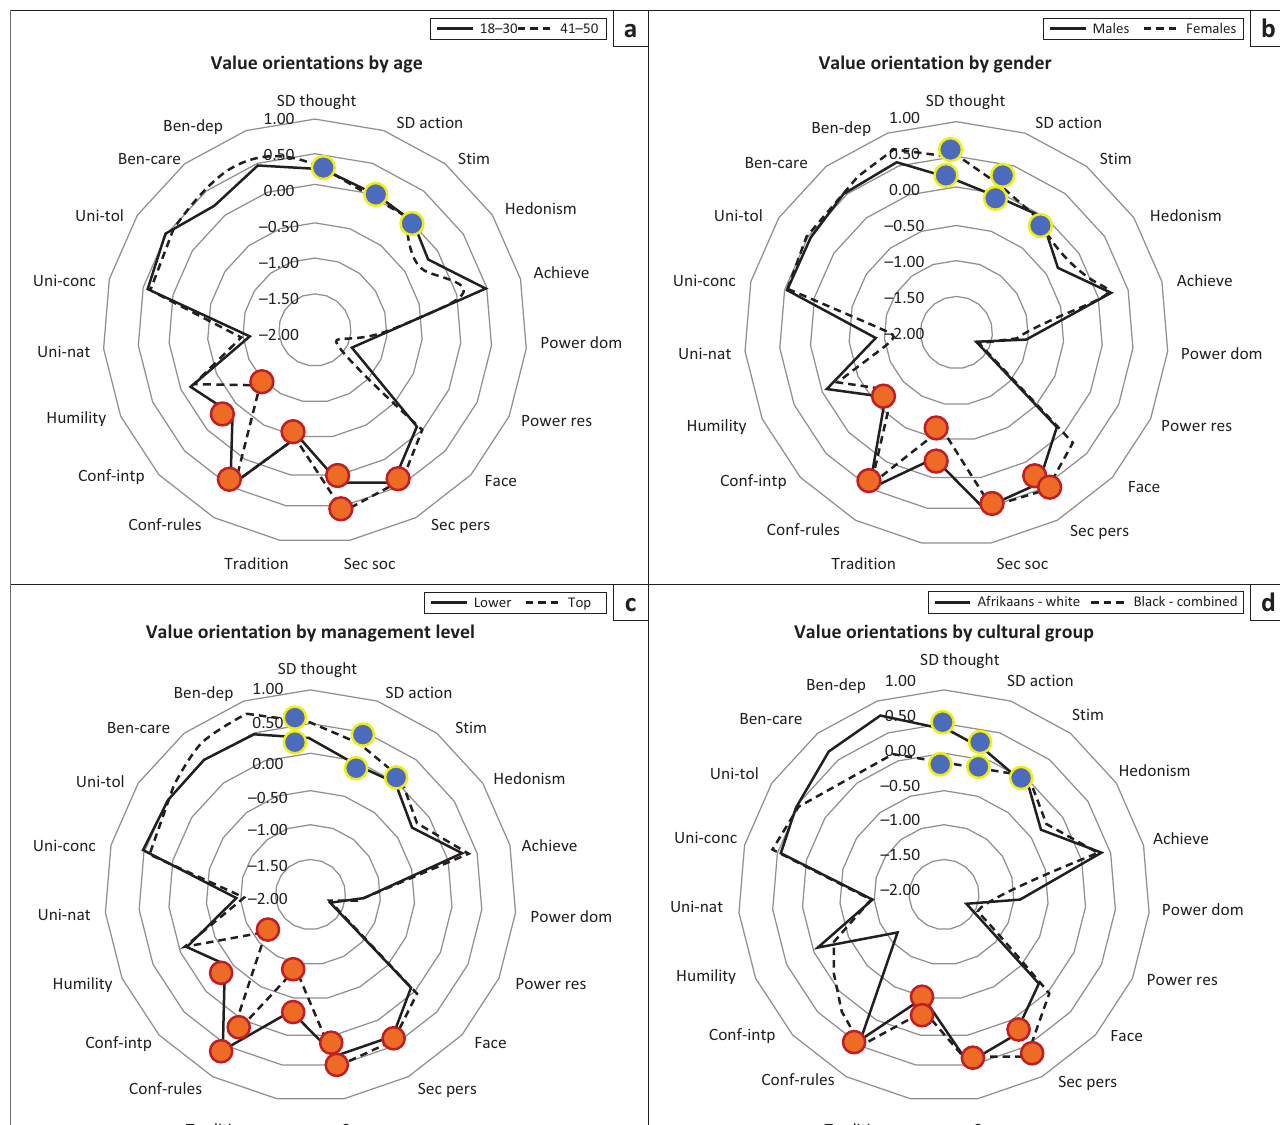
FIG URE 1: Value orientations and demographic groupings; (a) value orientations by age; (b) value orientation by gender; (c) value orientation by management level; (d) value orientations by cultural